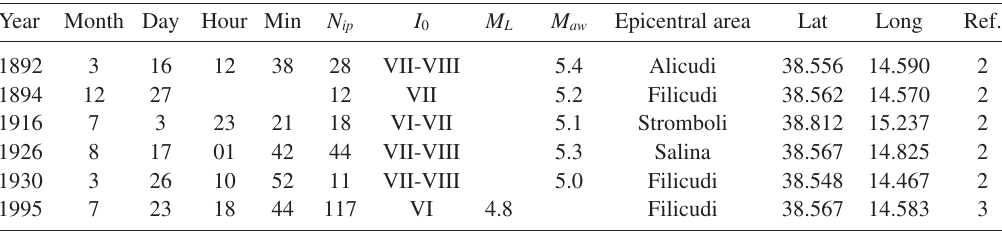
Table II. Dataset of the earthquakes selected for the Aeolian Islands. M aw , moment magnitude from CPTI Working Group (2004). Source of data: 2) Monachesi and Stucchi (1997); 3) Azzaro